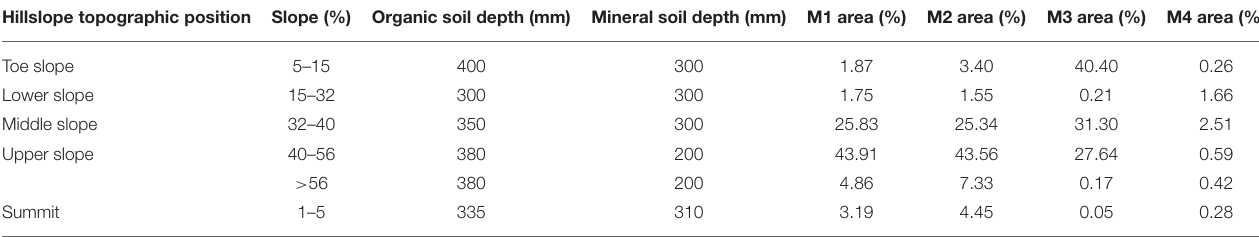
TABLE 2 | Zhurucay microcatchments soil